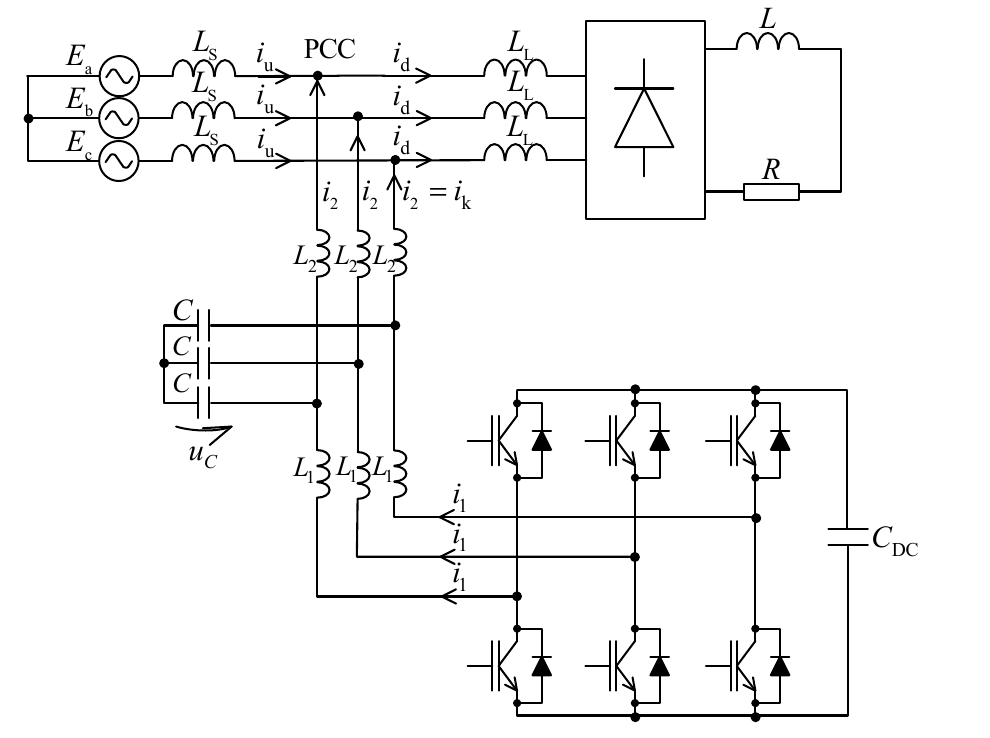
Figure 1. Main circuit structure. Table 1. Parameters of proposed system.